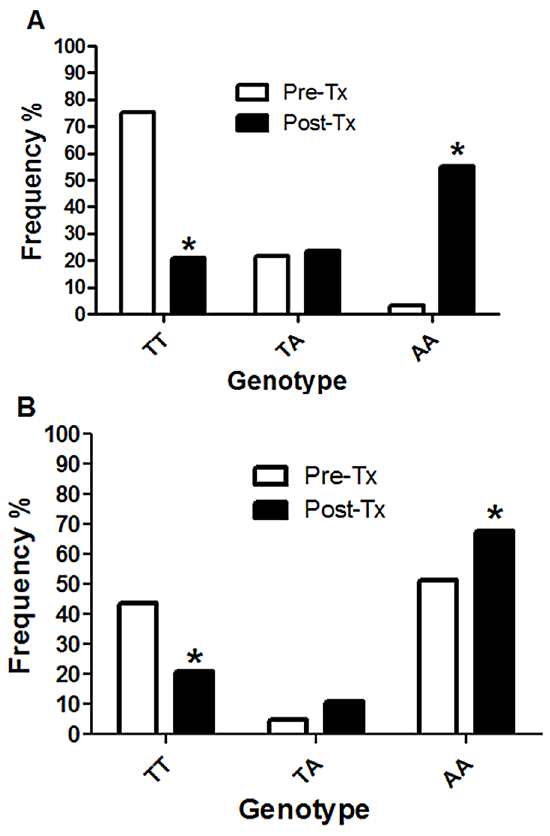
Figure 2. Genotype frequencies of the b -tubulin gene position 200 in T.trichiura from Haiti and Kenya. Genotype frequencies of T. trichura collected in Haiti (A) and in Kenya (B); Number of individual T. trichiura eggs genotyped according to the available material, in Haiti was 65 in the untreated group (pre-Tx) and 38 in the treated group (post-Tx), in Kenya was 40 in the untreated group and 90 in the treated group. Sequences were diploid, TT indicates the homozygous susceptible-type TTC/TTC, TA the heterozygous TTC/TAC and AA, the homozygous resistance-type TAC/TAC; Tx=treatment, *Indicates a significant difference (p , 0.001) in genotype frequency between the pre- and post treatment groups. P-values were obtained by Fisher’s exact